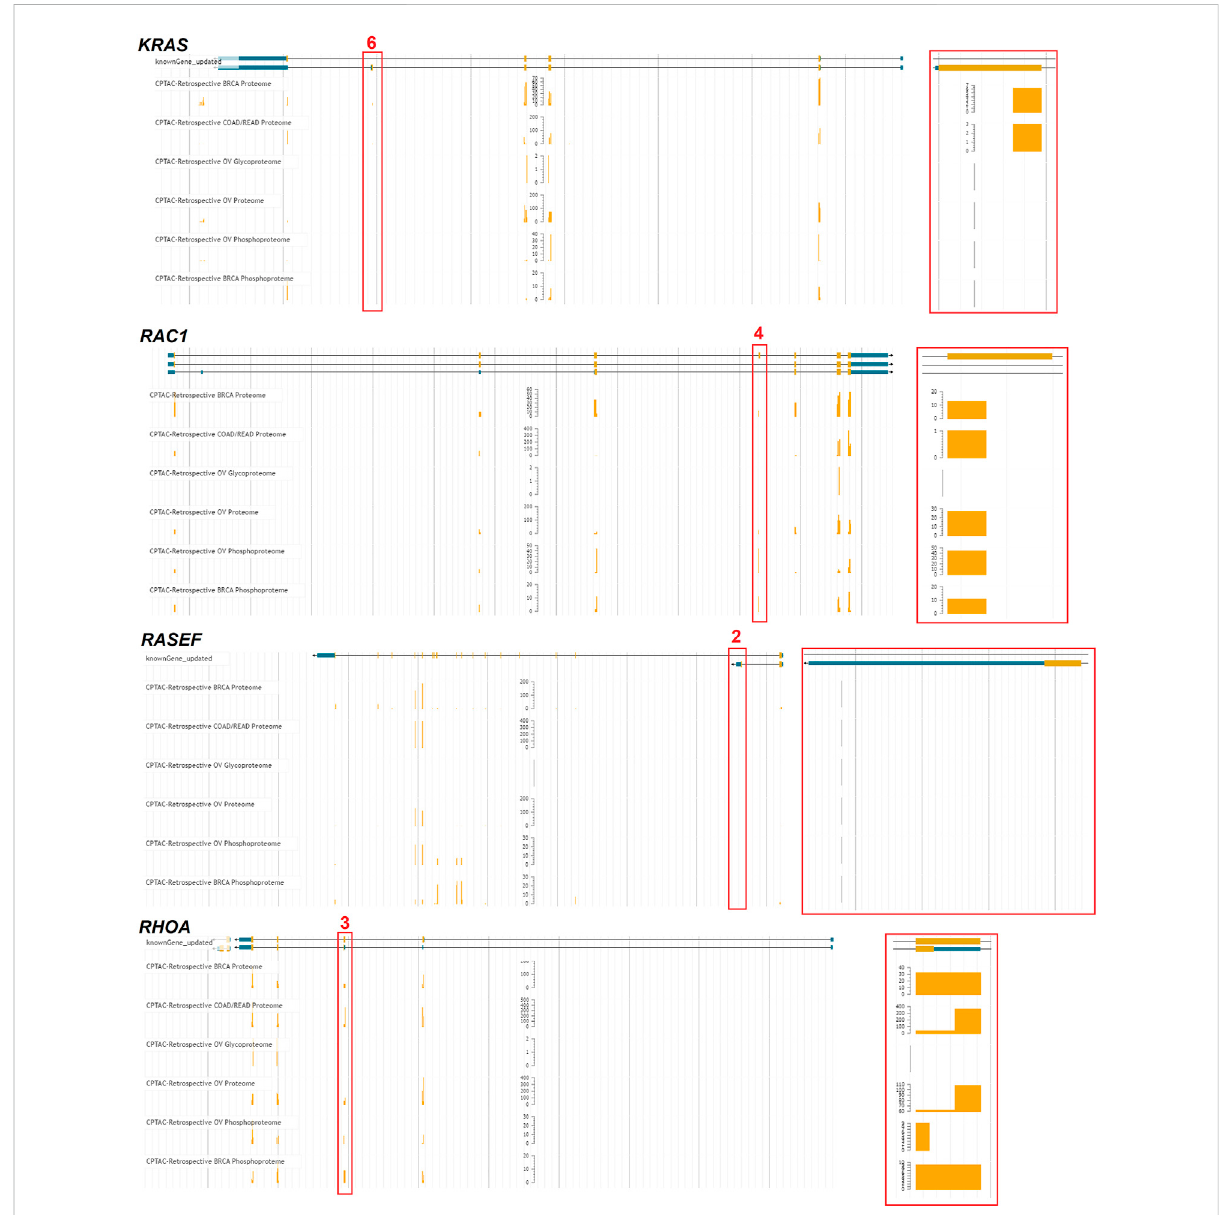
FIGURE 14 Proteomic analysis of exon skipping in cancer samples. Four genes ( KRAS , RAC1 , RASEF , RHOA ) with identi fi ed exon skipping were processed throughtheTCGApeptidegenomemappingtool(https://pdc.cancer.gov/jbrowse/).ExonsnotedinFigure13weremarkedinred,withazoominon that exon shown to the right. The yellow bars represent the amount of peptide mapped in six different proteomic datasets.